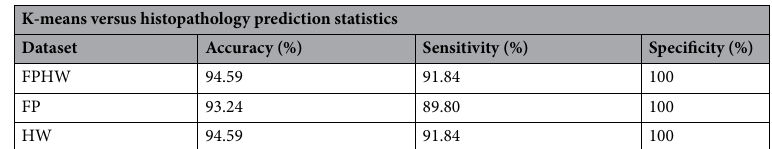
Table 3. Prediction statistics for comparison between histopathology gold standard for 0% (n = 25) and 100% (n = 49) quintile categories and the unsupervised k-means prediction (k = 2) for FP, FPHW and HW datasets.